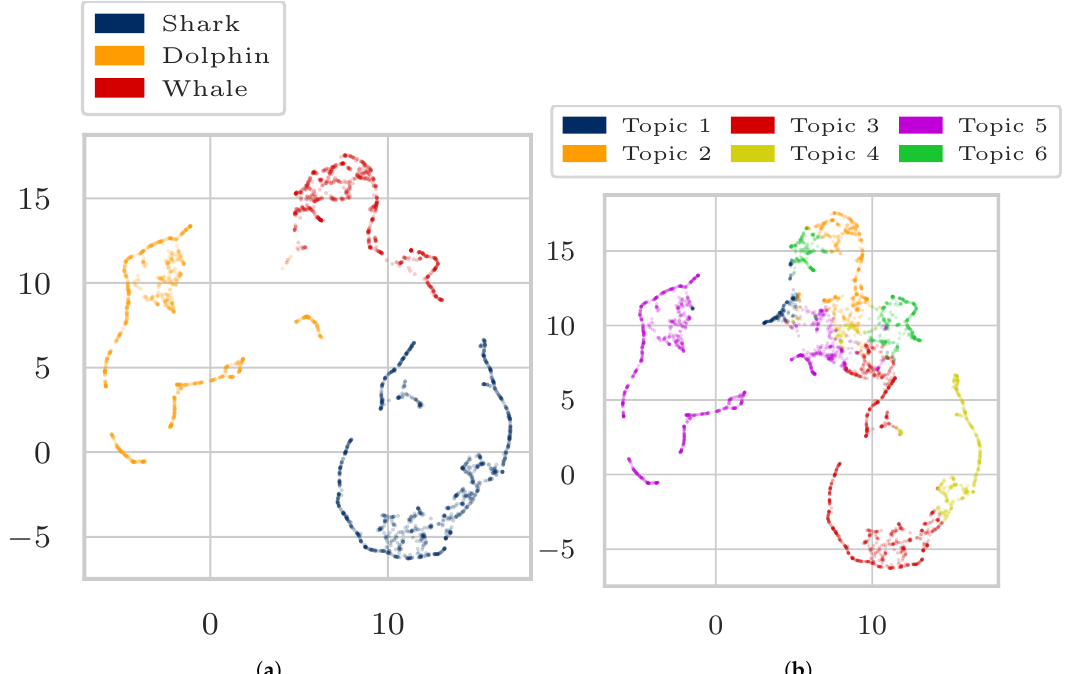
Figure A6. ( a ) 2-dimensional representation of word embeddings A colored by topic assignment. ( b ) 2-dimensional representation of word embeddings A colored by original Wikipedia article assignment (words that occur in more than one article are excluded).